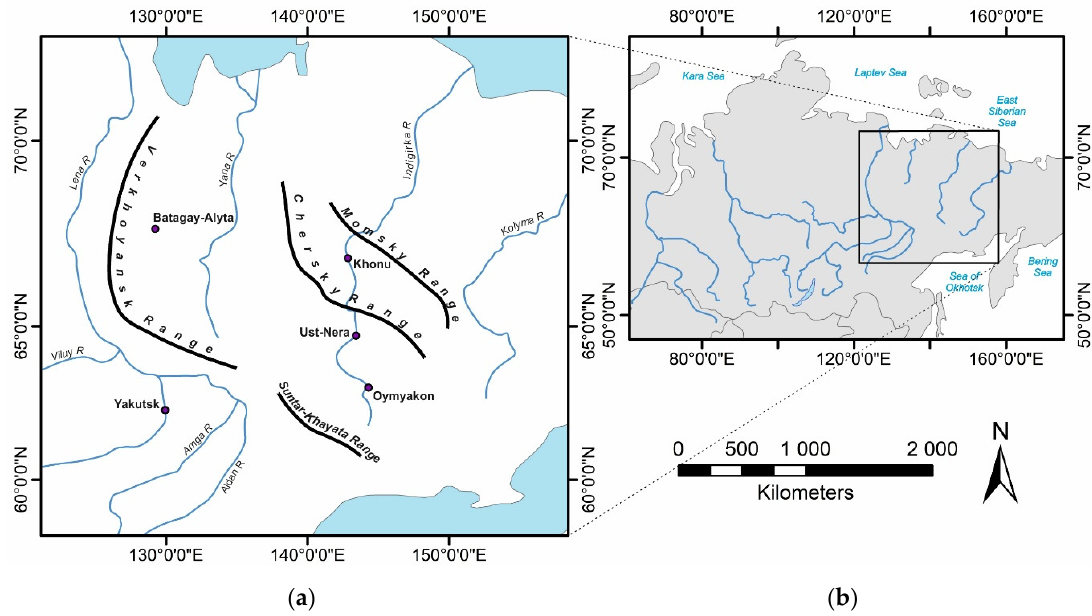
Figure 1. Map of the research area ( b ). The black lines indicate the watershed parts of the mountain ranges ( a ).